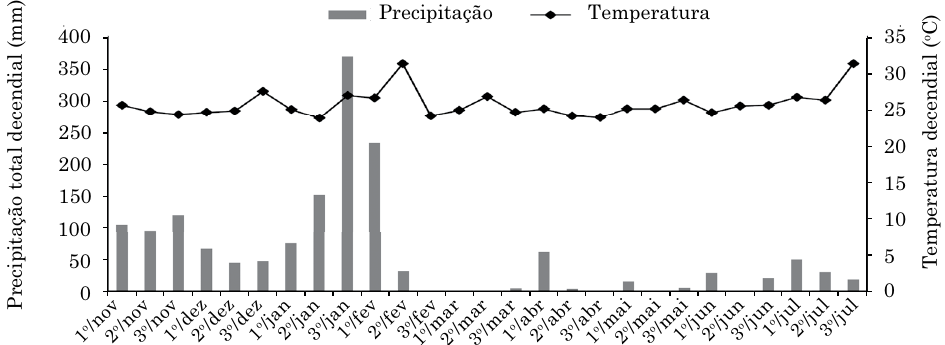
Figura 1. Precipitação pluvial total e temperatura média do ar em cada decêndio na área experimental, no período de novembro de 2012 a julho de